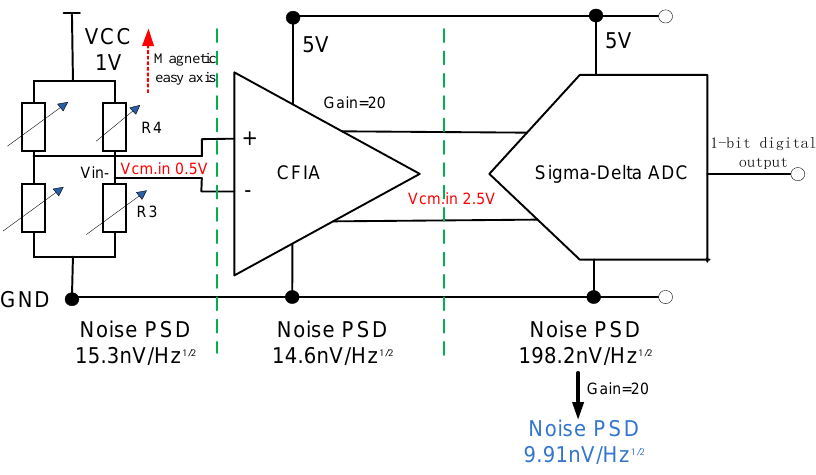
Figure 4. The noise performance of TMR sensor element, instrumentation amplifier and Sigma-Delta Figure modulator.